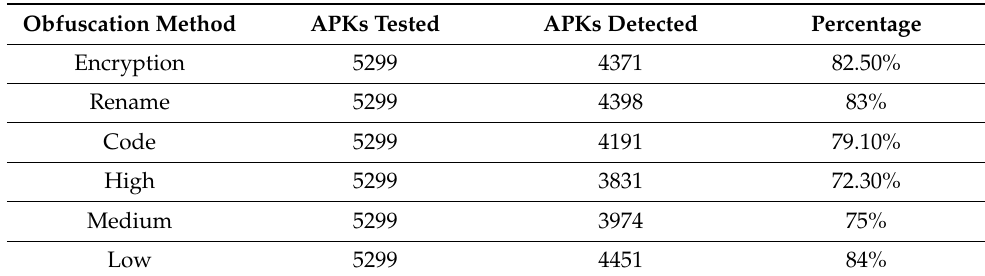
Table 8. Detection Ratio based on Static